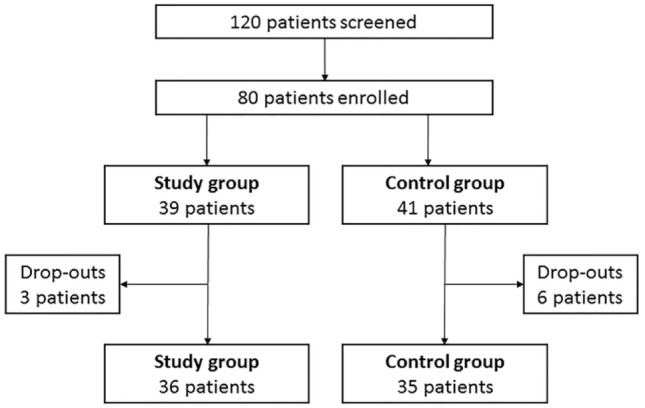
Flow chart of the study.